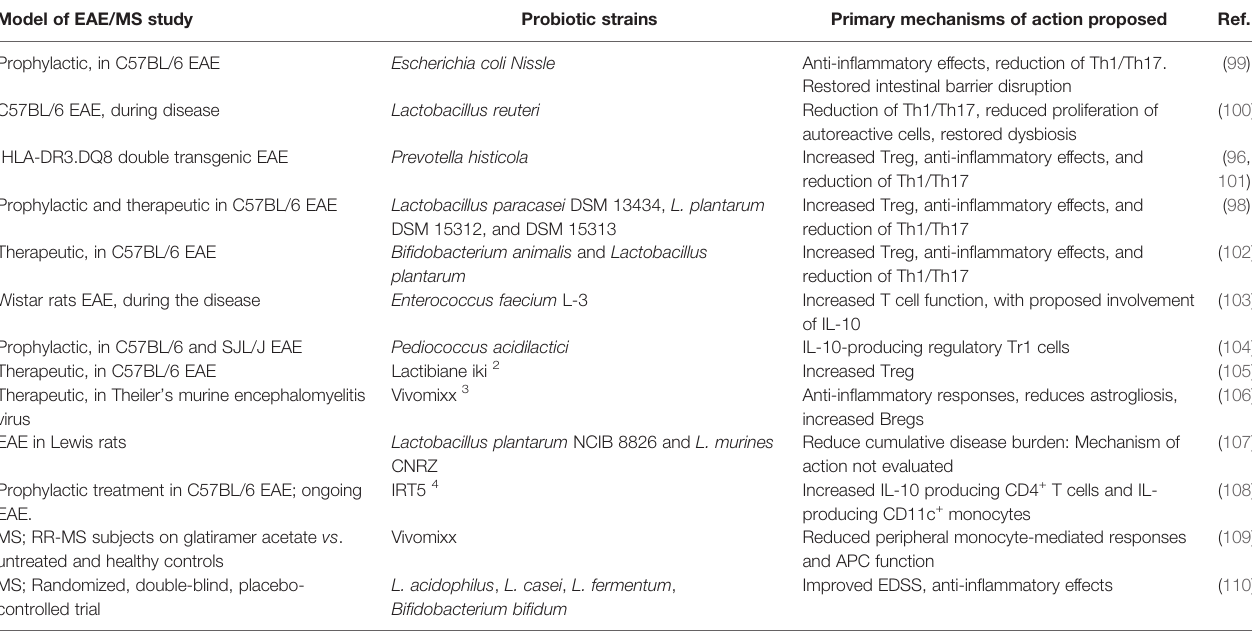
TABLE 1 | Single probiotic species and probiotic multi-species mixes evaluated for protection in murine EAE 1 and MS clinical studies. Model of EAE/MS